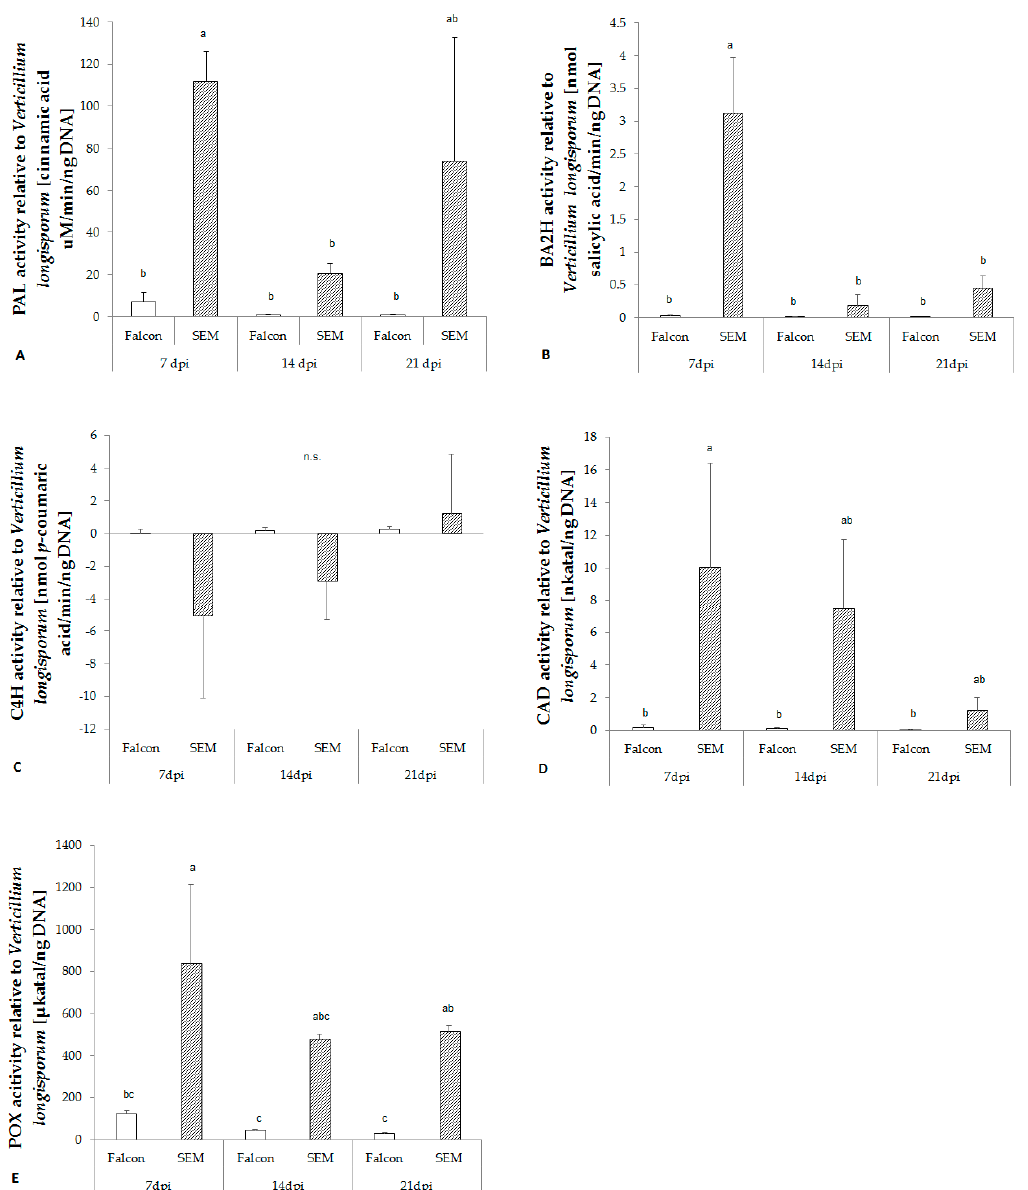
Figure 3. Response of free benzoic acid ( A ), salicylic acid ( B ) and different phenolic acids ( C–L ) in the hypocotyl of B. napus cv. Falcon and SEM upon infection of V. longisporum . Bars indicate standard errors. Different letters indicate significant differences among the treatments (LSD test, P < 0.05). FW, fresh weight; n.s., no significant difference.